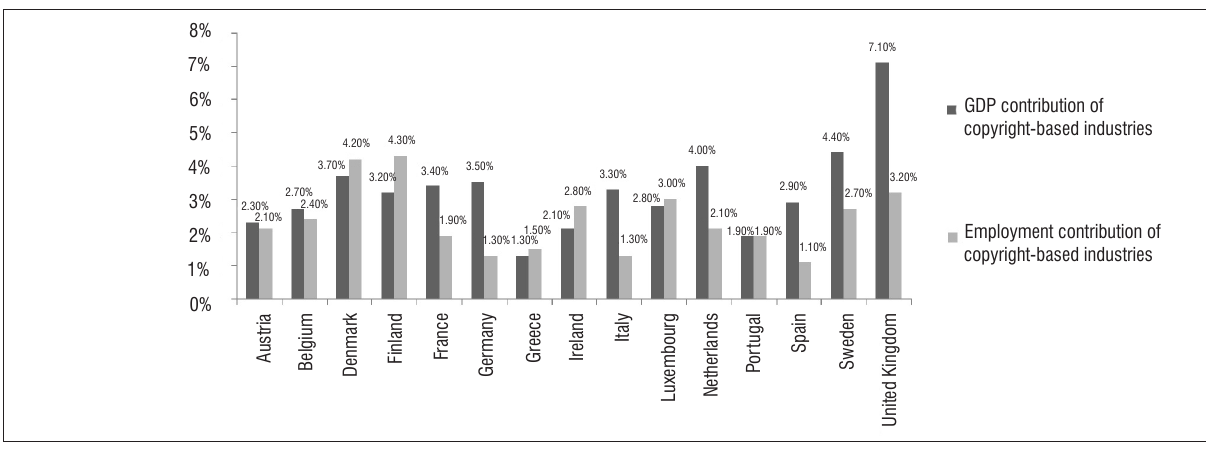
Contribution of copyright-based industries to GDP and employment in various countries.